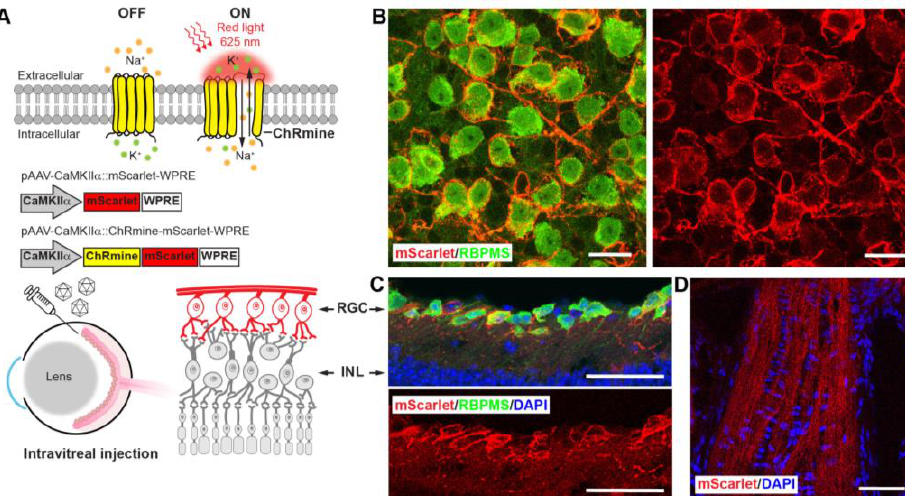
Figure 3. Transduction of mouse RGCs to express ChRmine using AAV delivery. ( A ) Schematic illustration of ChRmine optogenetic stimulation mechanism, AAV vector designs, and intravitreal injection of viral vector to transduce RGC layers. ( B ) Representative confocal images of whole-mount mouse retina. ( C , D ) Representative confocal images of the retina tissues ( C ) and optic nerve head ( D ) in mouse retinal cryosections at 21 days post-injection. ChRmine-mScarlet expression: red, RGC marker of RBPMS: green, nuclei stained with DAPI: blue. Scale bars: 20 µ m ( B ) and 50 µ m ( C , D ). WPRE, woodchuck hepatitis virus posttranscriptional regulatory element; RGC, retinal ganglion cells; INL, inner nuclear layer; RBPMS, RNA binding protein with multiple splicing factors; DAPI, 4′,6 -diamidino-2-phenylindole.